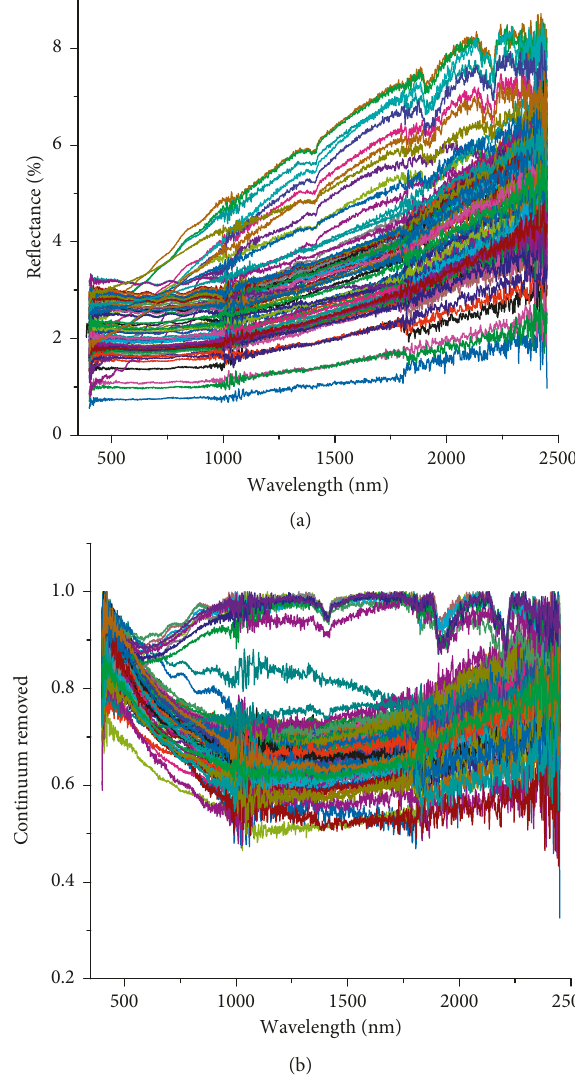
Figure 7: Spectral reflectance curves (a) and continuum-removed spectral curves (b) of 200 modeling samples in the wavelength range of 350–2500nm.